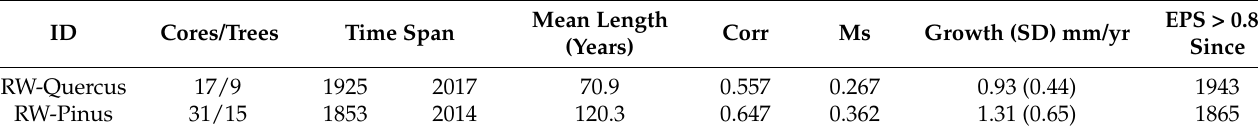
Table 2. Characteristics of the tree-ring width chronologies of Scots pine and pubescent oak. Corr, correlation with master series; Ms, mean sensitivity; EPS, expressed population signal.